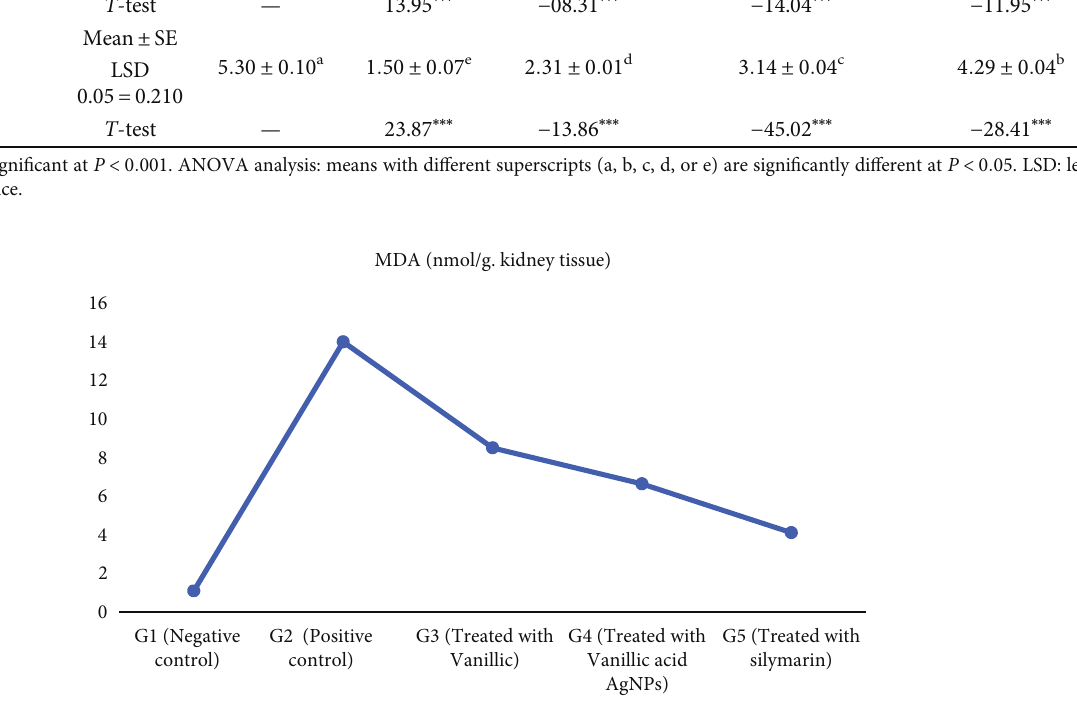
Figure 5: E ff ect of treating CCl -induced nephrotoxicity in male rats with vanillic acid, vanillic acid AgNPs, and silymarin on 4